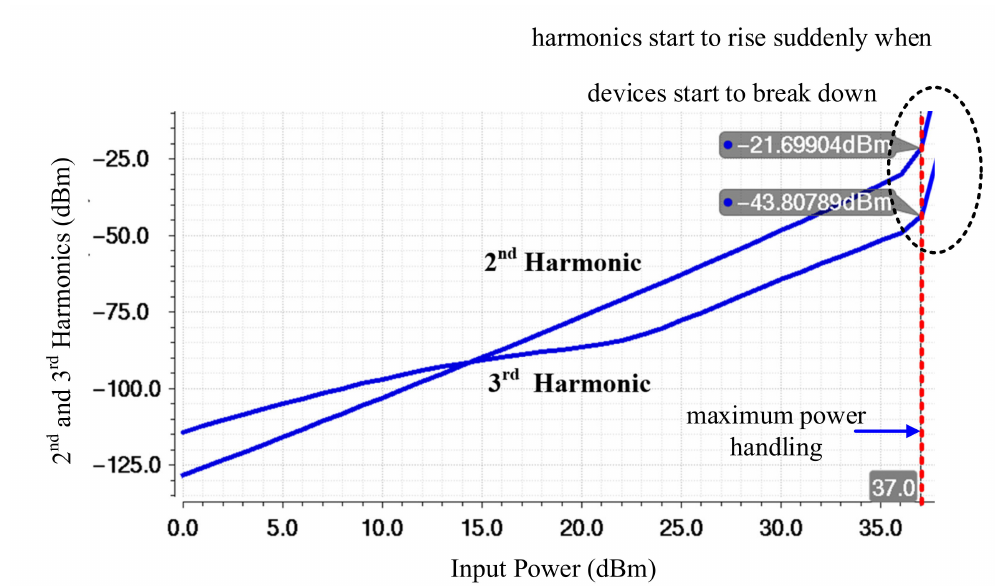
Figure 8. Analysis of power handling achieved by sweeping input power and monitoring the harmonics.